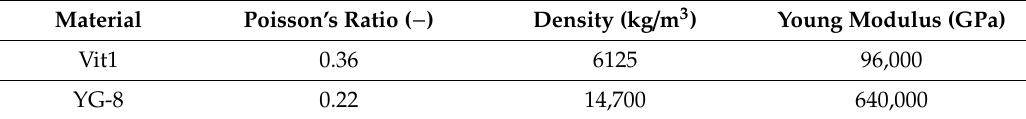
Table 4. Physical parameters of Bulk metallic glass (BMG) and turning tool.